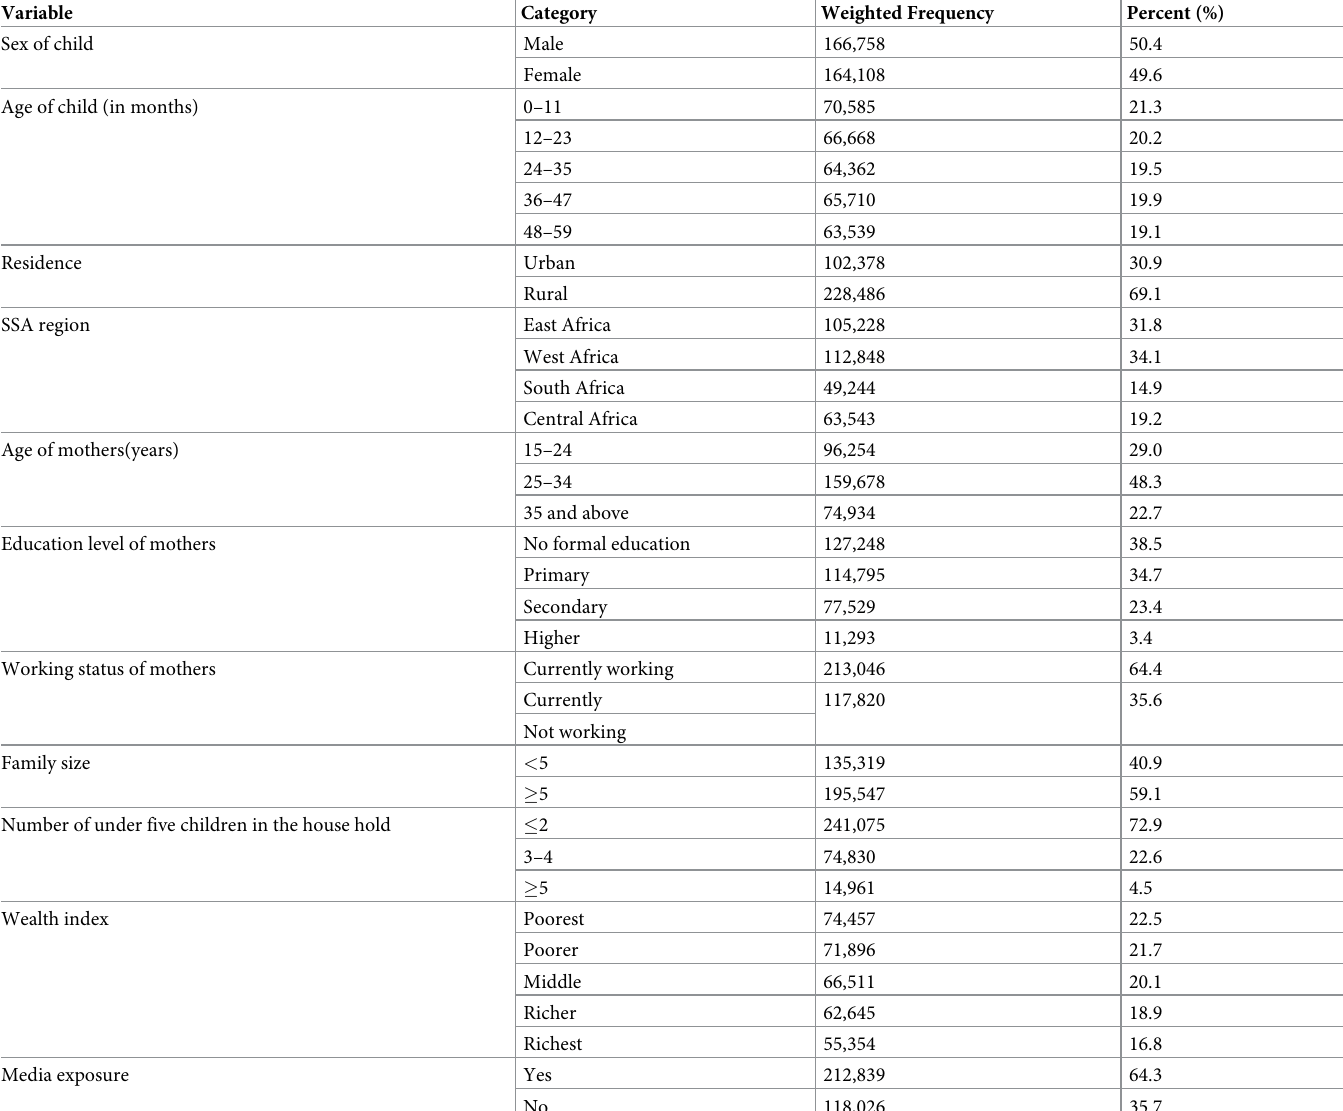
Table 2. Sociodemographic characteristics of the respondents in sub-Saharan